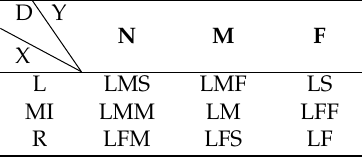
Figure 9. Membership functions of the left wheel speed w.r.t. moving target position. Table 1. Fuzzy rules of the left wheel speed for the fuzzy steering controller of dynamic tracking.